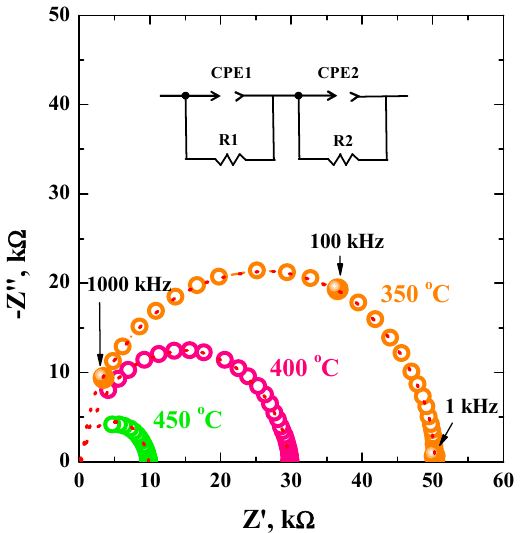
Table 4. The Nyquist plots fitting results.